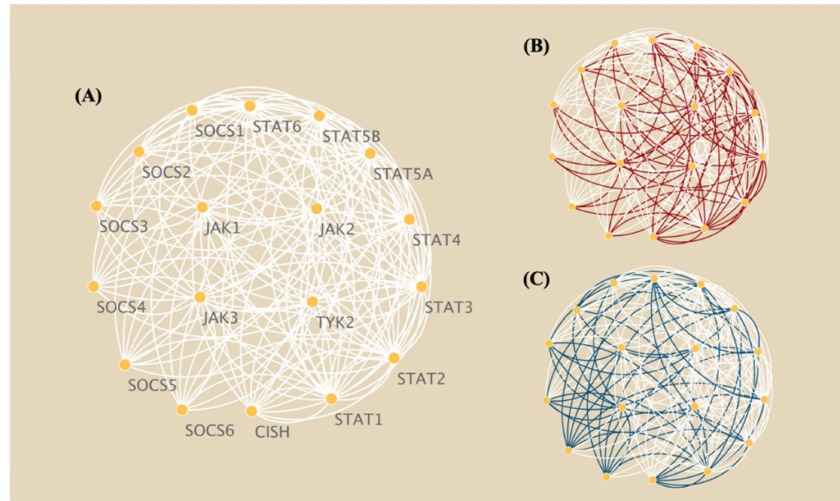
Figure 4. Simplified schematic diagrams of JAK-STAT-SOCS signaling and Clipper-reconstructed BNs from the original and randomly shuffled gene expression data. ( A ) Core paths of JAK-STAT signal transduction and SOCS negative feedback inhibition; ( B ) reconstructed BN (edges in red) from gene expression data of paired tumor and non-tumor HCC patients; ( C ) reconstructed BN (edges in dark blue) from shuffled gene expressions across